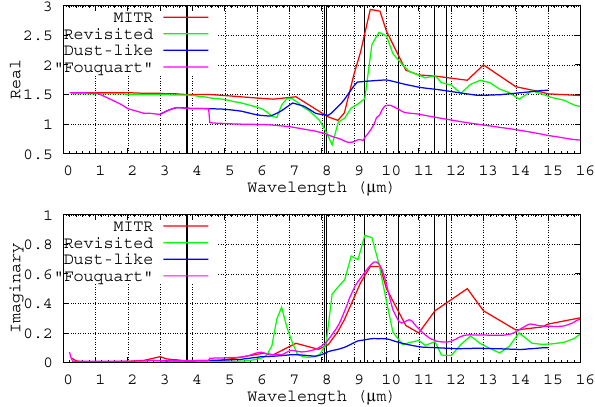
Figure A1. Mean values ( ± one standard deviation) of r eff and σ g for the 38 AERONET sites analysed in this study (see Table 1). The standard deviation associated with each site corresponds to the variability of the parameter considered over the whole time period analysed (July 2007–June 2013).